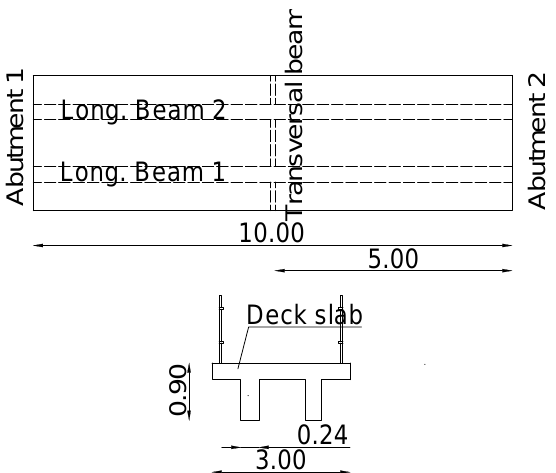
Figure 5: P08 Bridge Structural Scheme.